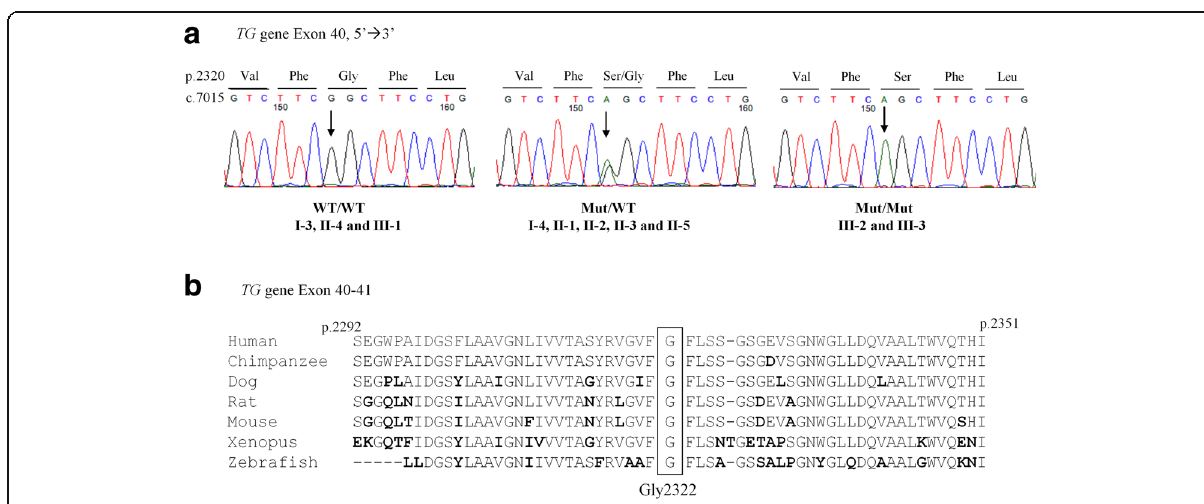
Fig. 4 a Direct sequencing for normal (Wild type/Wild type), heterozygote (Mutant/Wild type) and homozygote (Mutant/Mutant) covering the region of the mutation in exon 40 of the TG gene (c.7021G > A, pGly2322Ser). b Alignment of the TG amino acid sequence encoded by exons 40 and 41 containing the mutant Gly2322 in various species including mammals, amphibian and fish. Amino acid differences are in bold type. Abbreviations: WT; Wild type, Mut; Mutant